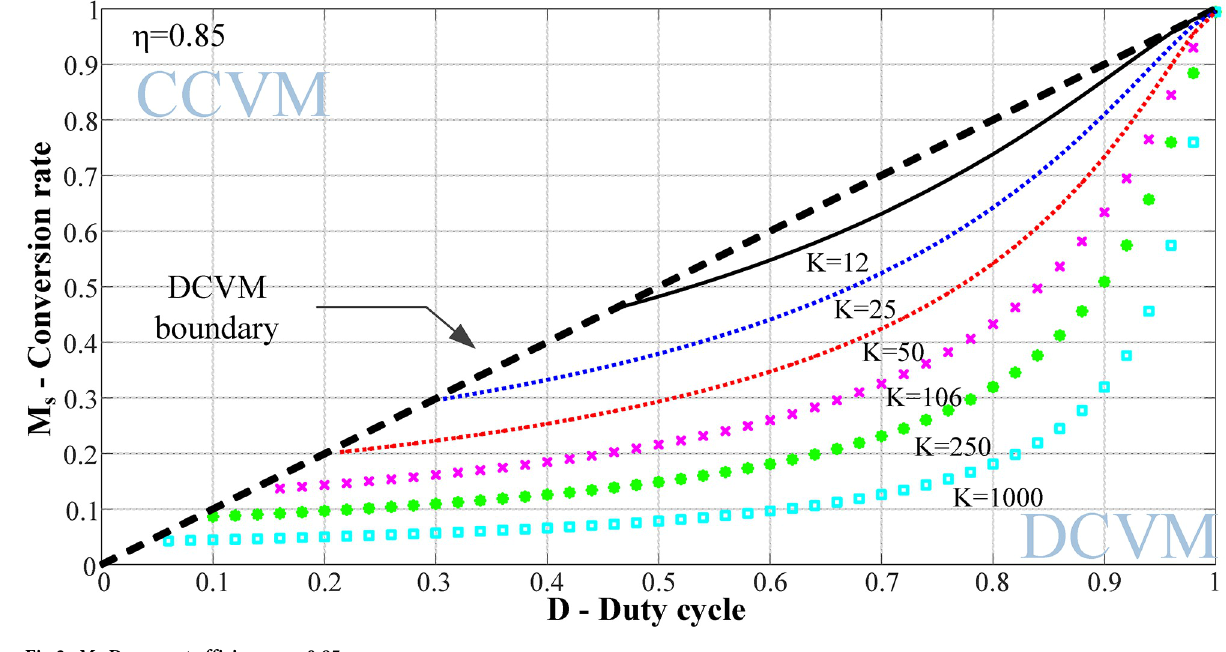
Fig 3. M s - D curve at efficiency η